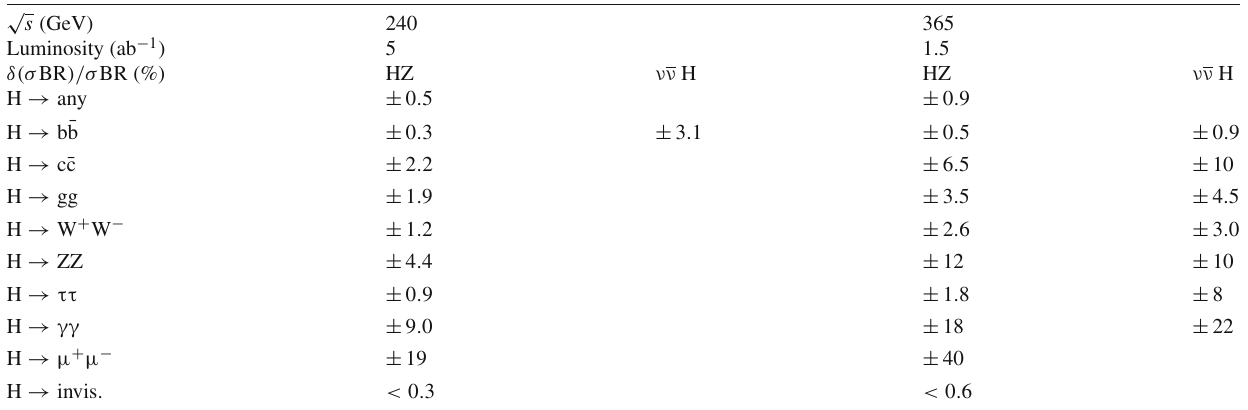
Fig. 4.2 Left: a schematic view, transverse to the detector axis, of an e + e − → HZ event with Z → μ + μ − and with the Higgs boson decay- ing hadronically. The two muons from the Z decay are indicated. Right: distribution of the mass recoiling against the muon pair, determined Table 4.1 Relative statistical uncertainty on the measurements of event rates, providing σ HZ × BR ( H → XX ) and σ ν ¯ ν H × BR ( H → XX ) , as expected from the FCC-ee data. This is obtained from a fast simulation of the CLD detector and consolidated with extrapolations from full simulations of similar linear-collider detectors (SiD and CLIC). All numbers indicate 68% C.L. intervals, except for the 95% C.L. sensitivity in the last line. The accuracies expected with 5 ab − 1 at 240 GeV are given in the middle columns, and those expected with 1 . 5 ab − 1 at are displayed in the last columns